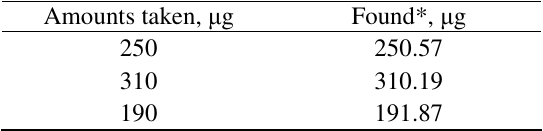
Table 3 . Analysis of synthetic